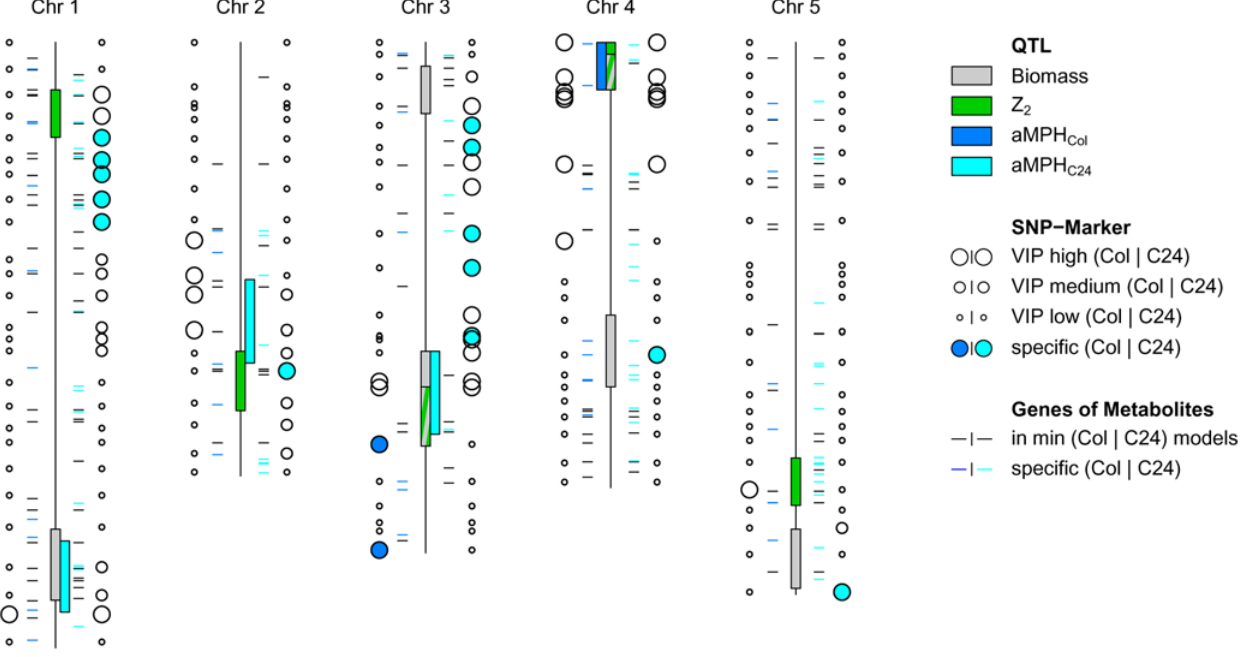
Figure 3. Discrete VIP of genetic markers for Col-heterosis and C24-heterosis prediction, including overlap with QTL. Each of the 110 genetic markers and its position on a Chromosome (Chr) is represented by two circles. The circle size indicates high (large circles), medium and low (small circles) VIP in the genetic model for Col-heterosis (circle left of chromosome) and C24-heterosis prediction (circle right of chromosome). We refer to the VIP as high and medium, if the corresponding marker is contained in the minimal genetic model and in the optimal genetic model, respectively. Markers specific for Col-heterosis prediction and those specific for C24-heterosis prediction are coloured in dark blue and in light blue, respectively. To allow positional comparison, support intervals of biomass QTL and three kinds of heterosis related QTL detected by Meyer et al. (2008, submitted) are plotted as coloured boxes along the chromosomes (grey: biomass, green: Z2 [40], dark blue: absolute mid-parent heterosis concerning Col-0, referred to as aMPH_Col, light blue: absolute mid-parent heterosis concerning C24, referred to as aMPH_C24). Horizontal lines represent the position of genes directly involved in reactions including metabolites, which are contained in the respective minimal metabolite model and the combined genetic-metabolic model (Col: left of chromosomes, C24: right of chromosomes). For specific metabolites genes were coloured accordingly.